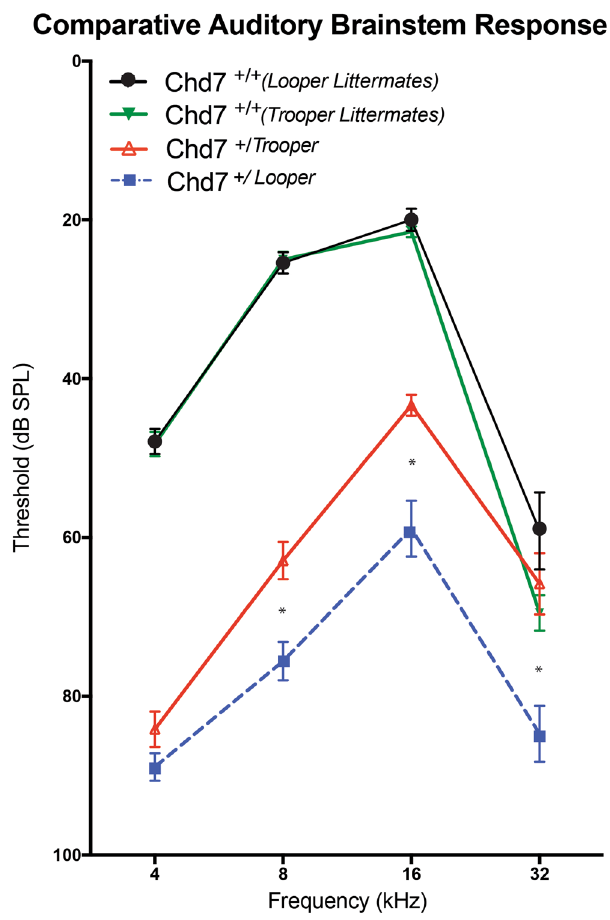
Figure 5. Trooper mice have a milder hearing phenotype than the previously reported Looper strain. Average ABR thresholds of Chd7 + /Trooper , Chd7 + /Looper , and their Chd7 + / + controls. The hearing of Trooper mice is on average, significantly better than Looper mice ( * p < 0.002 based on t- tests performed with the Holm-Sidak correction for multiple comparisons). Chd7 + / Looper and the corresponding Chd7 + / + control cohort were previously published in Ogier et al . 9